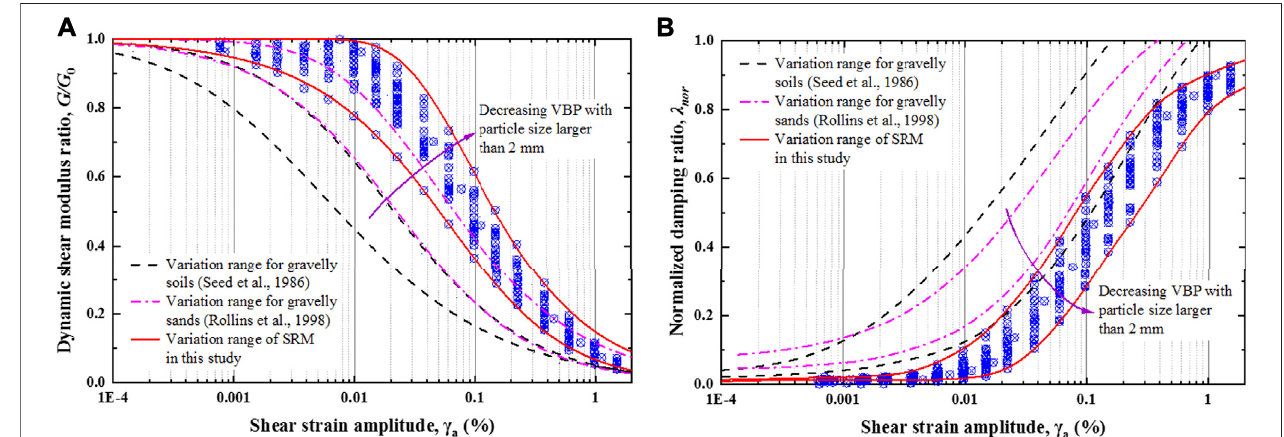
FIGURE 2 | Envelope curves of G/G 0 and λ of SRM with different VBPs and CPs.